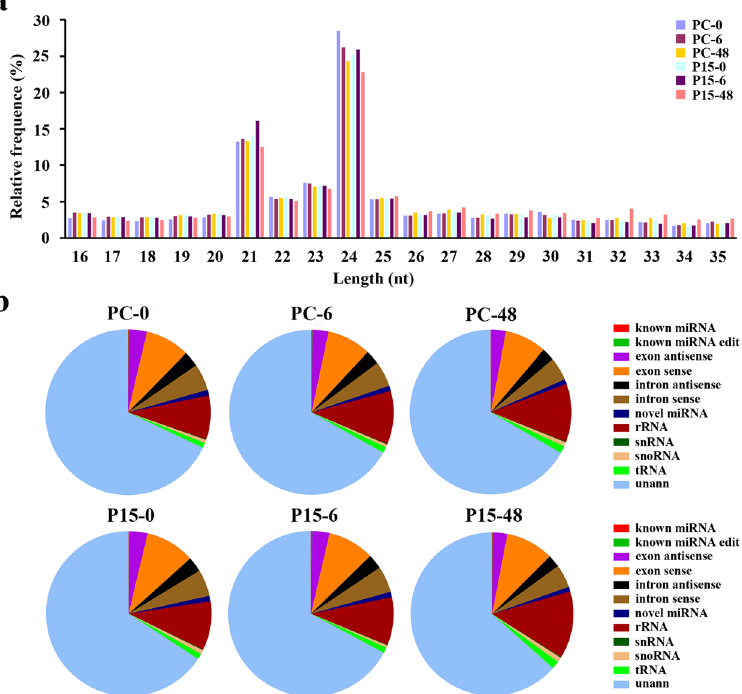
Figure 1. Size distribution and annotation of small RNAs from the libraries of the resistant BPH15 introgression line (P15) and susceptible recipient line (PC) at 0 h, 6 h, and 48 h after BPH infestation. ( a ) Length distribution of sequenced reads. The most abundant sRNAs in both libraries were 21 nt and 24 nt in length. ( b ) Proportions of different classes of small RNAs detected in the six libraries.